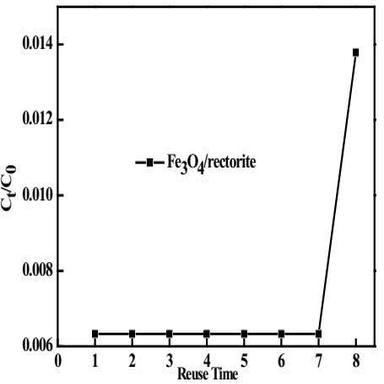
Reuse of the catalyst.